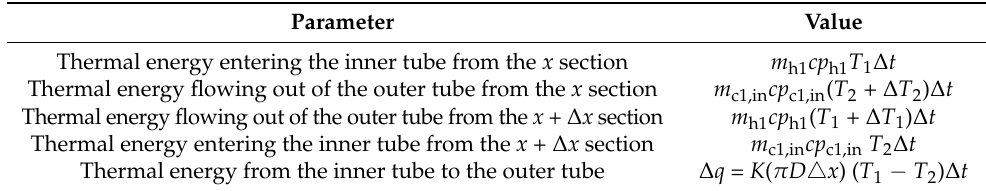
Table 2. Thermal Parameters of the Dual Tube Heat Exchanger.